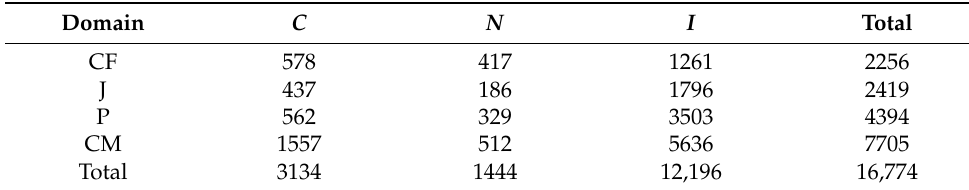
Table 1. The statistics of the